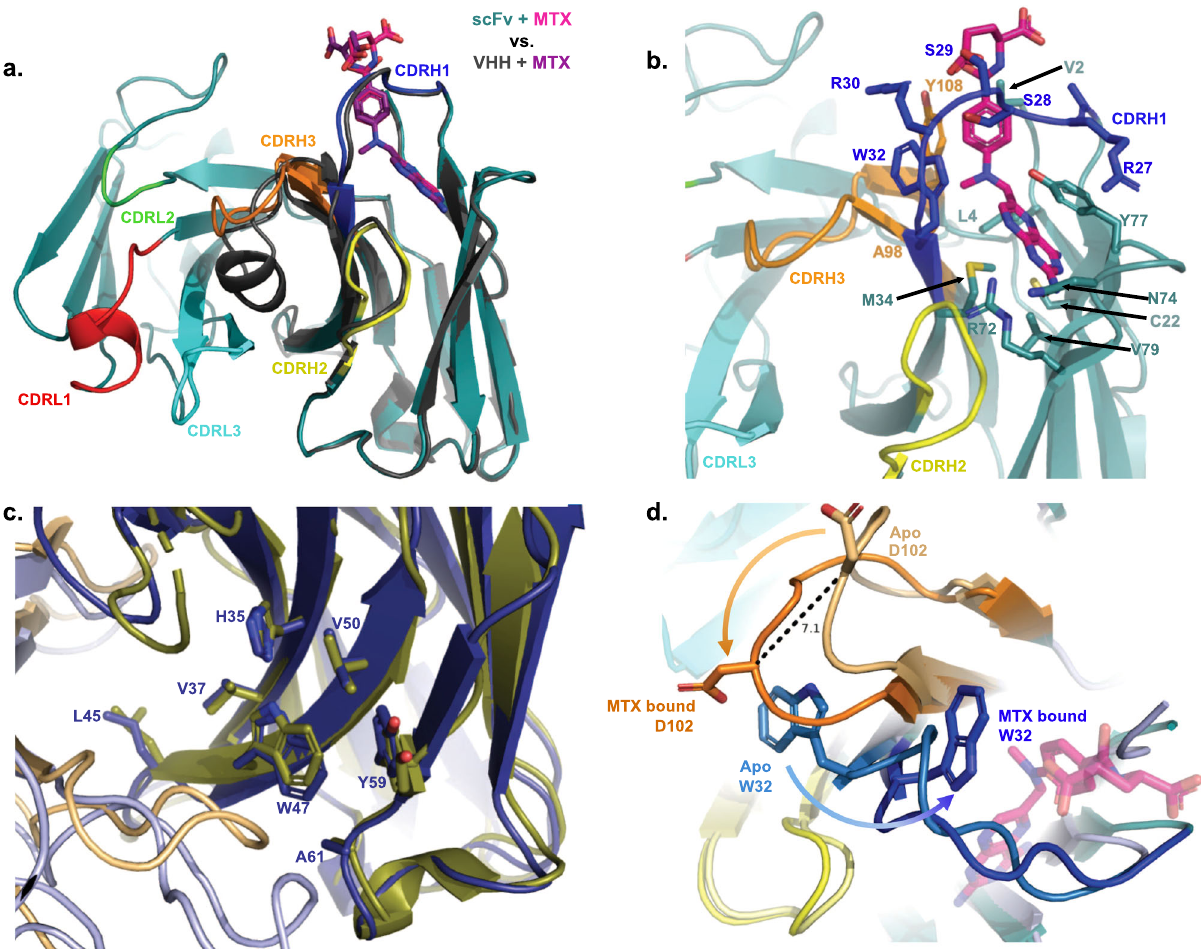
Fig. 2 Structures of the conditional scFv P02_D09 were determined with or without MTX. a Comparison with the previous V HH structure bound to MTX (PDB code: 3QXV) demonstrates the presence of the light chain does not signi fi cantly perturb the MTX binding site. Structures are shown in cartoon rendering with scFv framework in deep teal, CDRHs 1, 2, and 3 shown in blue, yellow, and orange, respectively, CDRLs 1, 2, and 3 shown in red, green, and cyan, respectively, and MTX shown as magenta sticks. V HH + MTX is shown in a black cartoon with MTX as purple sticks. b A more detailed view of MTX bound to the conditional scFv shows MTX sitting underneath CDRH1 while also interacting with FW3. Residues contacting MTX are noted in the fi gure. c Alignment of the apo scFv structure (deep blue, HC and light blue, LC) with parental antibody M2J1 (deep olive, HC and light orange, LC) highlighting the interface between V H and V L . Side chains of mutations that revert the original V HH sequence back to the M2J1 sequence to stabilize the interface are shown as sticks. d Zoomed in view of the transition between apo and MTX-bound scFv P02_D09 highlighting the inward fl ip of W32 in CDRH1 upon MTX binding and the corresponding movement of D102 in CDRH3. Structures are shown as cartoon and colored as in ( a ) with noted side chains and MTX shown as